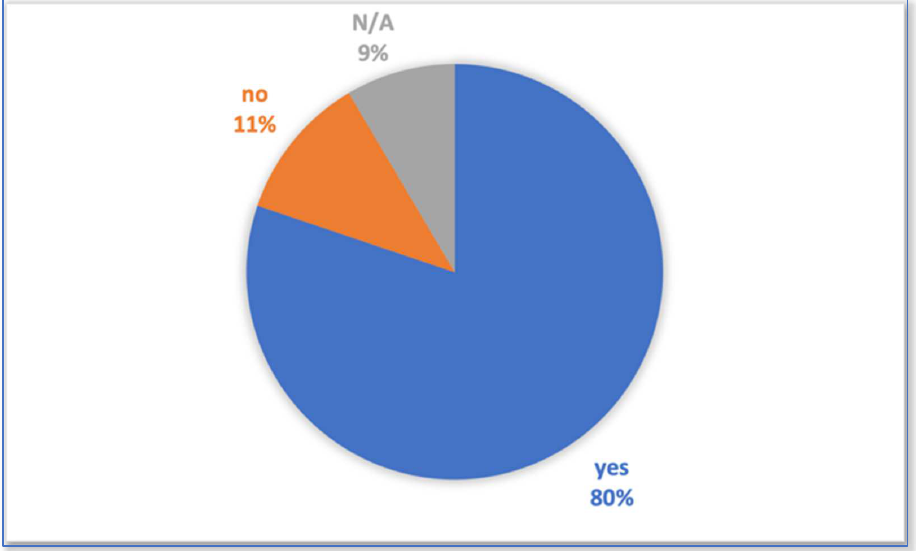
Figure 8. Results of a questionnaire regarding student satisfaction level.